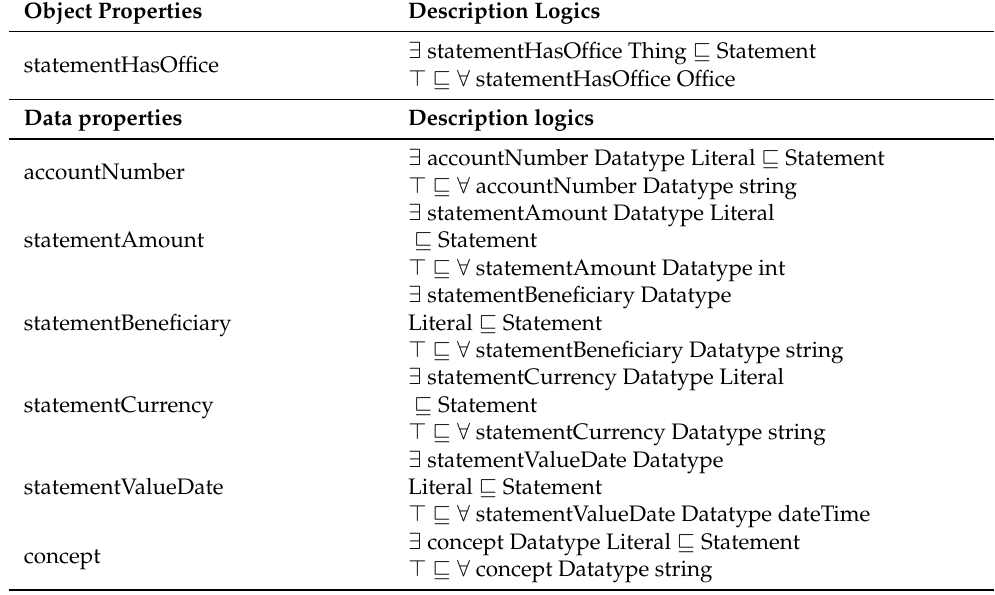
Table 5. Data and object properties of class